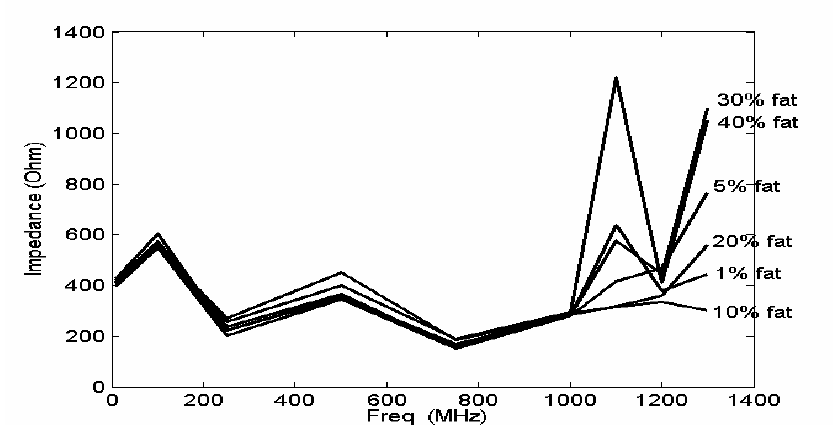
Figure 32. The impedance magnitude as a function of frequency for milk with different fat content at a lift-off of 5 mm.